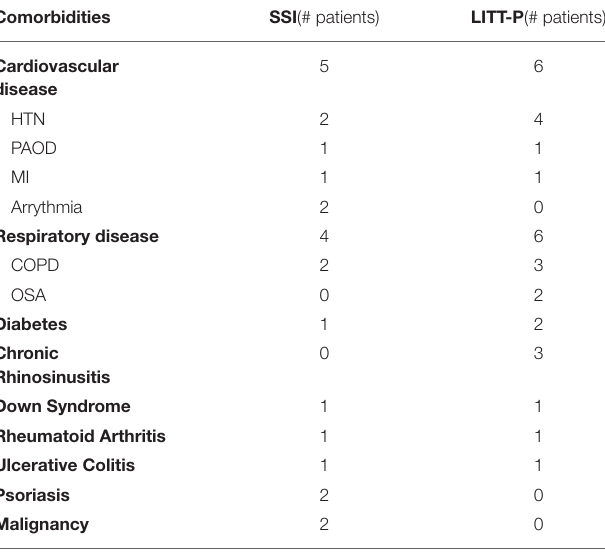
TABLE 1 | Patient characteristics. TABLE 2 | Comorbidities.